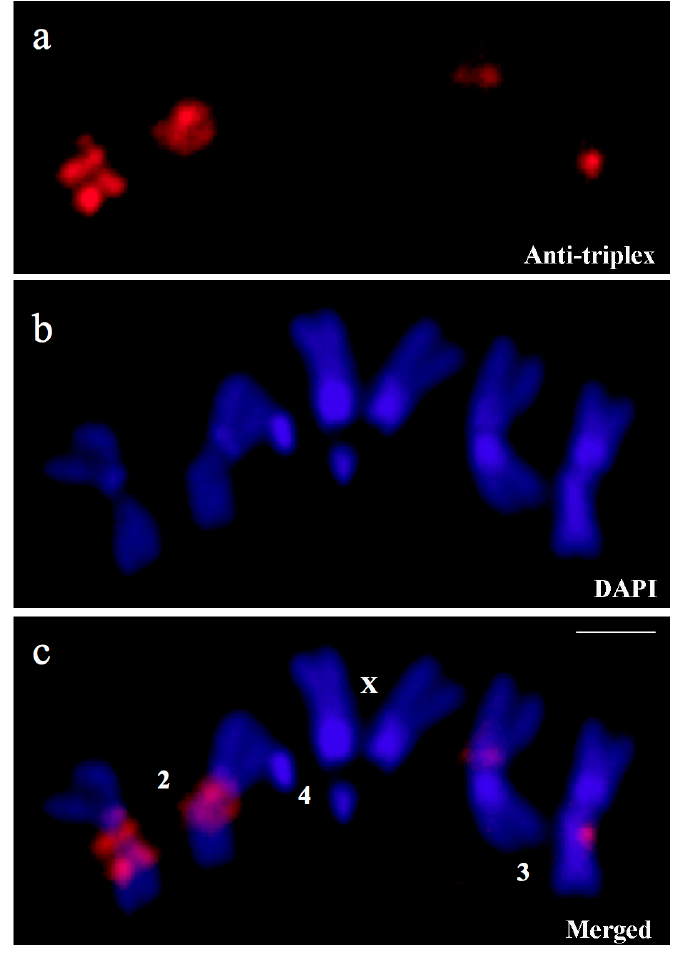
Figure 3. Neuroblast chromosomes from wild type larva stained with antibodies ( a , Anti-triplex), chromosomal DNA staining with DAPI ( b , DAPI) and the corresponding merged signals ( c , Merged) showing centromeric regions of D. melanogaster chromosomes reactive to anti-triplex DNA antibodies. Chromosomes appear identified (2, 3, 4, X). Scale bar corresponds to 5 µm.